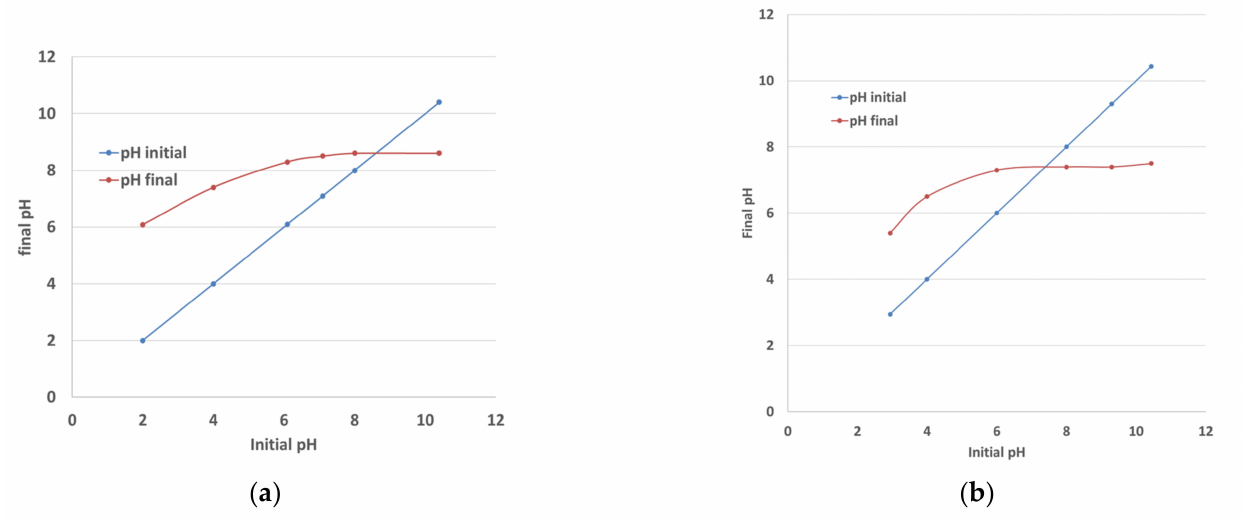
Figure 9. The values of pHpzc of the beech biochar_heat_oxid ( a ) and beech biochar_citric acid treated ( b